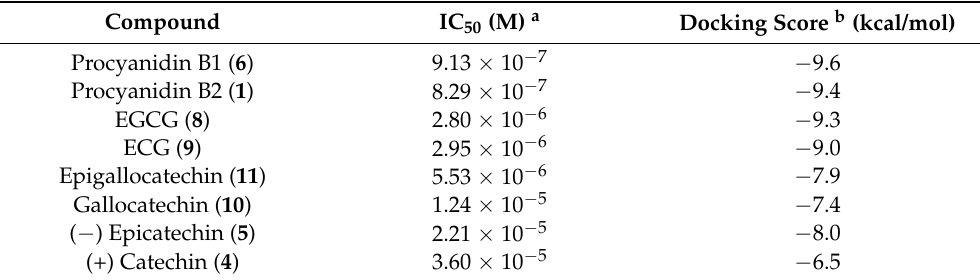
Table 2. The correlation between the docking score and the IC 50 values for B-type procyanidins, flavan-3-ols, and their analogues.